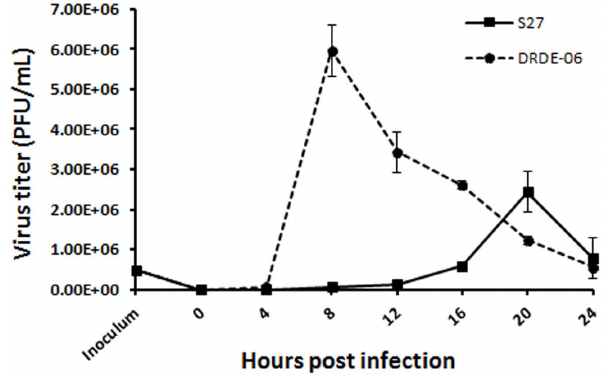
Figure 3. Growth kinetics of S-27 and DRDE-06 Chikungunya virus strains. Vero cells were infected with viruses and supernatants were collected at different time intervals. Growth curves were obtained by plotting viral titres present at each time. Virus titres were calculated from three independent experiments.